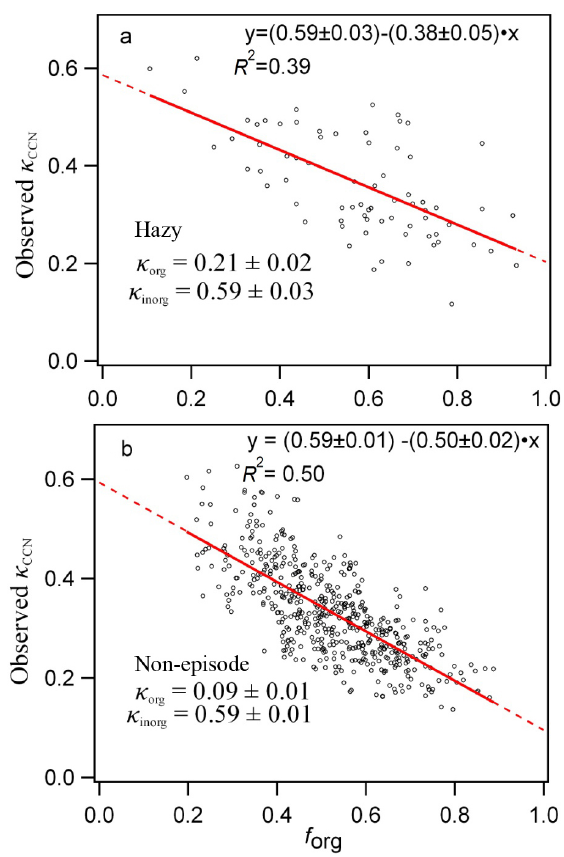
Figure 4. Correlations between the observed κ CCN and the organic volume fraction ( f org ) determined by size-resolved AMS measure- ments for the (a) hazy period ( n = 72) and (b) the non-episode pe- riod ( n = 516). The red line is the linear least squares fit ( p value